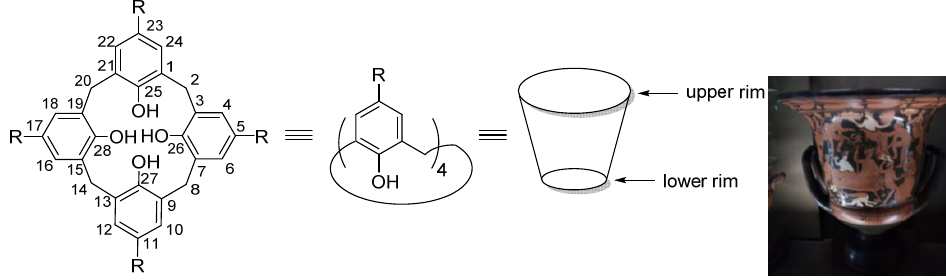
Figure 5. Molecular structure of calix[4]arenes.